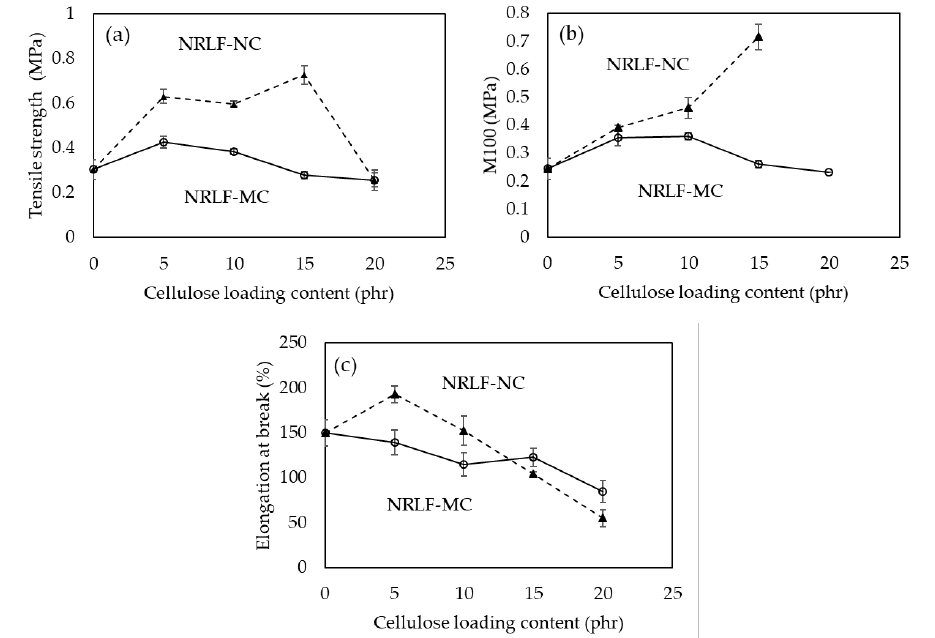
Figure 6. Mechanical properties: ( a ) tensile strength, ( b ) M100 and ( c ) elongation at break of NRLF, 327 NRLF-MC and NRLF-NC. 328